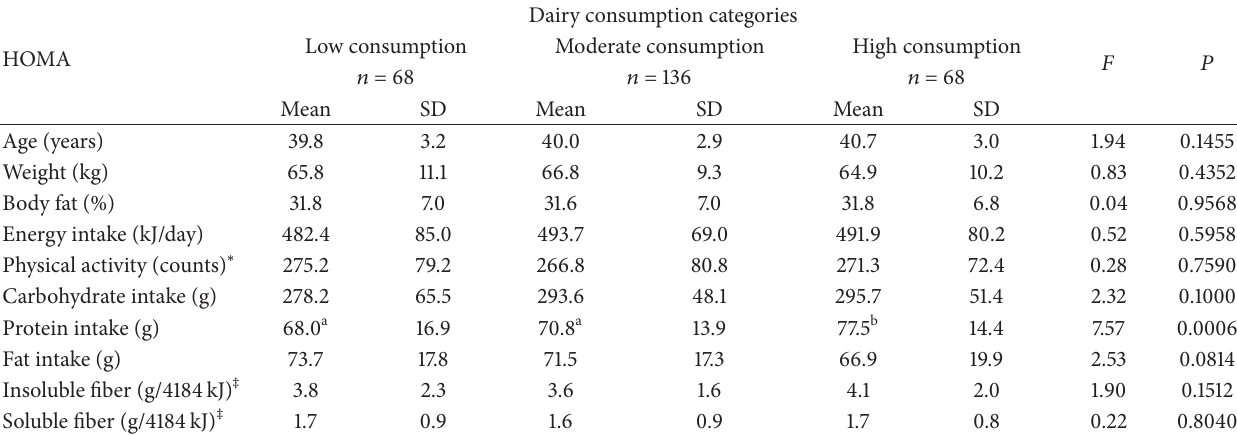
Table 2: Mean differences in the potential confounders across the dairy intake